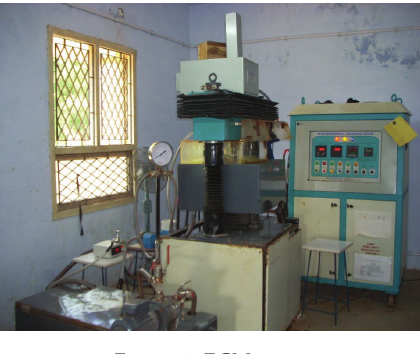
Figure 1: ECM setup. Table 1: Chemical composition of HCHCr die tool steel. Element